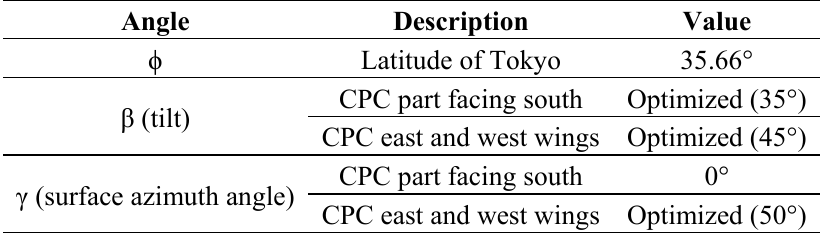
Table A1. Angle settings for each CPC